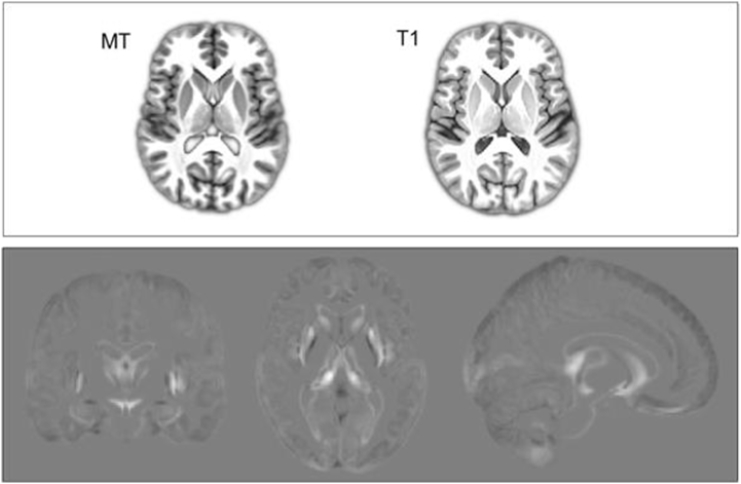
Top: Group averages of MT saturation compared to T1 show enhanced subcortical contrast. Bottom: Difference (MT-T1) in image intensity of segmented averaged maps showing enhanced contrast and segmentation in subcortical regions.